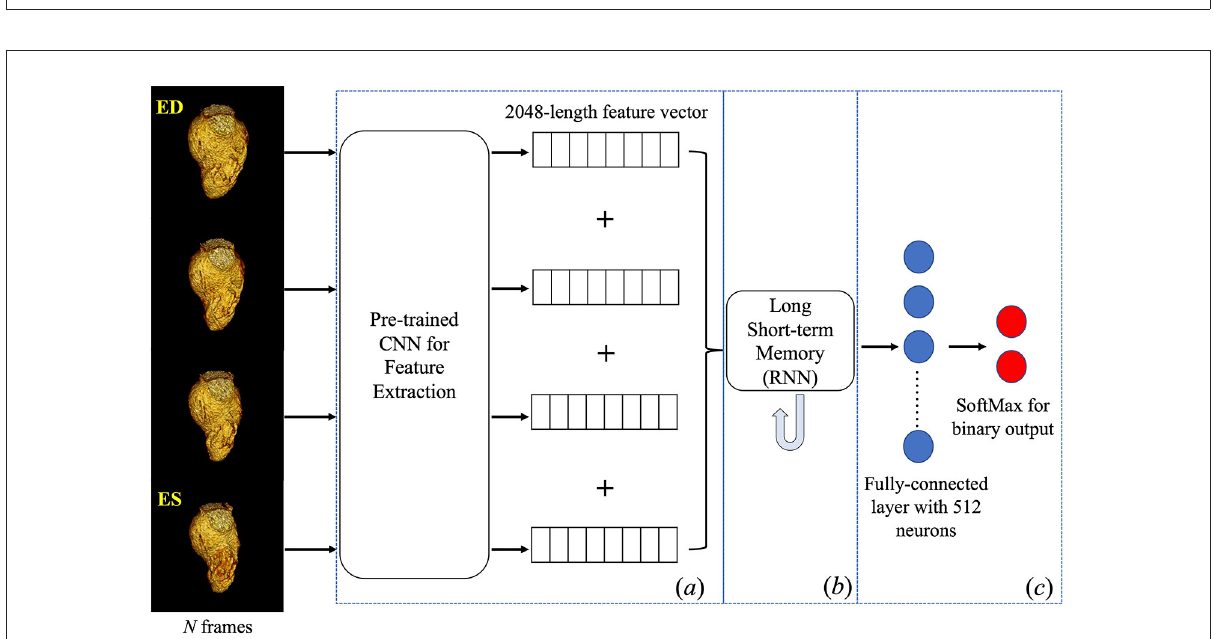
FIGURE2 Deep learning framework. Four frames were input into a pre-trained inception-v3 individually to obtain a 2048-length feature vector for each frame. Four vectors were concatenated into a feature matrix which was then input to the next components in the framework. A Long Short-term Memory followed by fully connected layers was trained to predict a binary classification of the presence of WMA in the video. CNN, convolutional neural network; RNN, recurrent neural